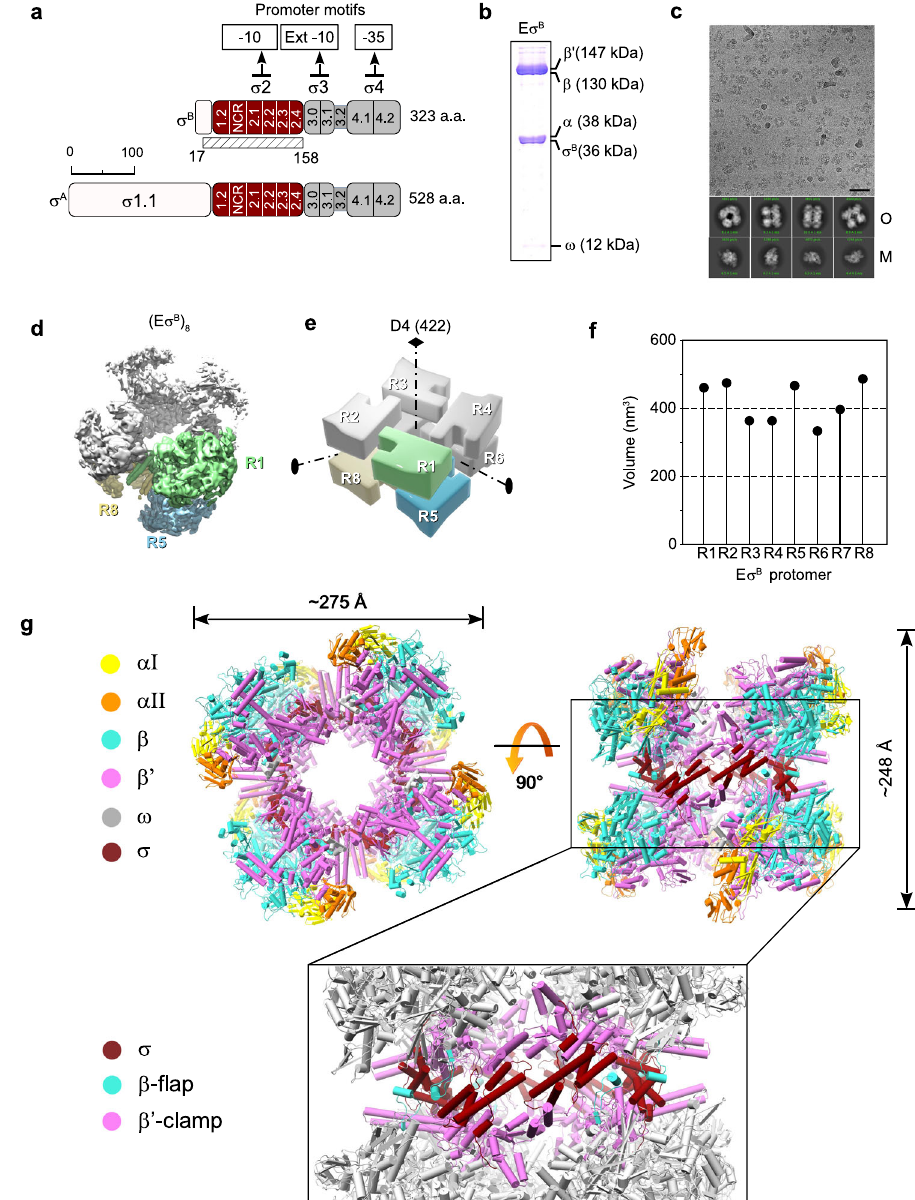
Fig. 1 | Cryo-EM structure of the M. tuberculosis E σ B octamer. a Schematic representation of the M. tuberculosis σ A and σ B subunits with the structural domains σ 1.1 in white, σ 2 in dark red, σ 3 and σ 4 in gray. The subregions inside the σ domains arenumbered.NCR,non-conservedregion.Thesolvedpartof σ B (residues17 – 158)is indicated by a hatched rectangle. b 14% SDS-PAGE of the E σ B sample for cryo-EM. c Representative cryo-EM image of the E σ B sample. Experiment was repeated inde- pendentlyfourtimes.Scalebar=50nm.Bottom,representative2Dclassaveragesof monomers (M) and oligomers (O). d Cryo-EM map of the octamer (E σ B ) 8 re fi ned without imposing symmetry ( C 1 -map). RNAP protomers with well-de fi ned density are in light green (protomer R1), sky blue (protomer R5), and khaki (protomer R8).